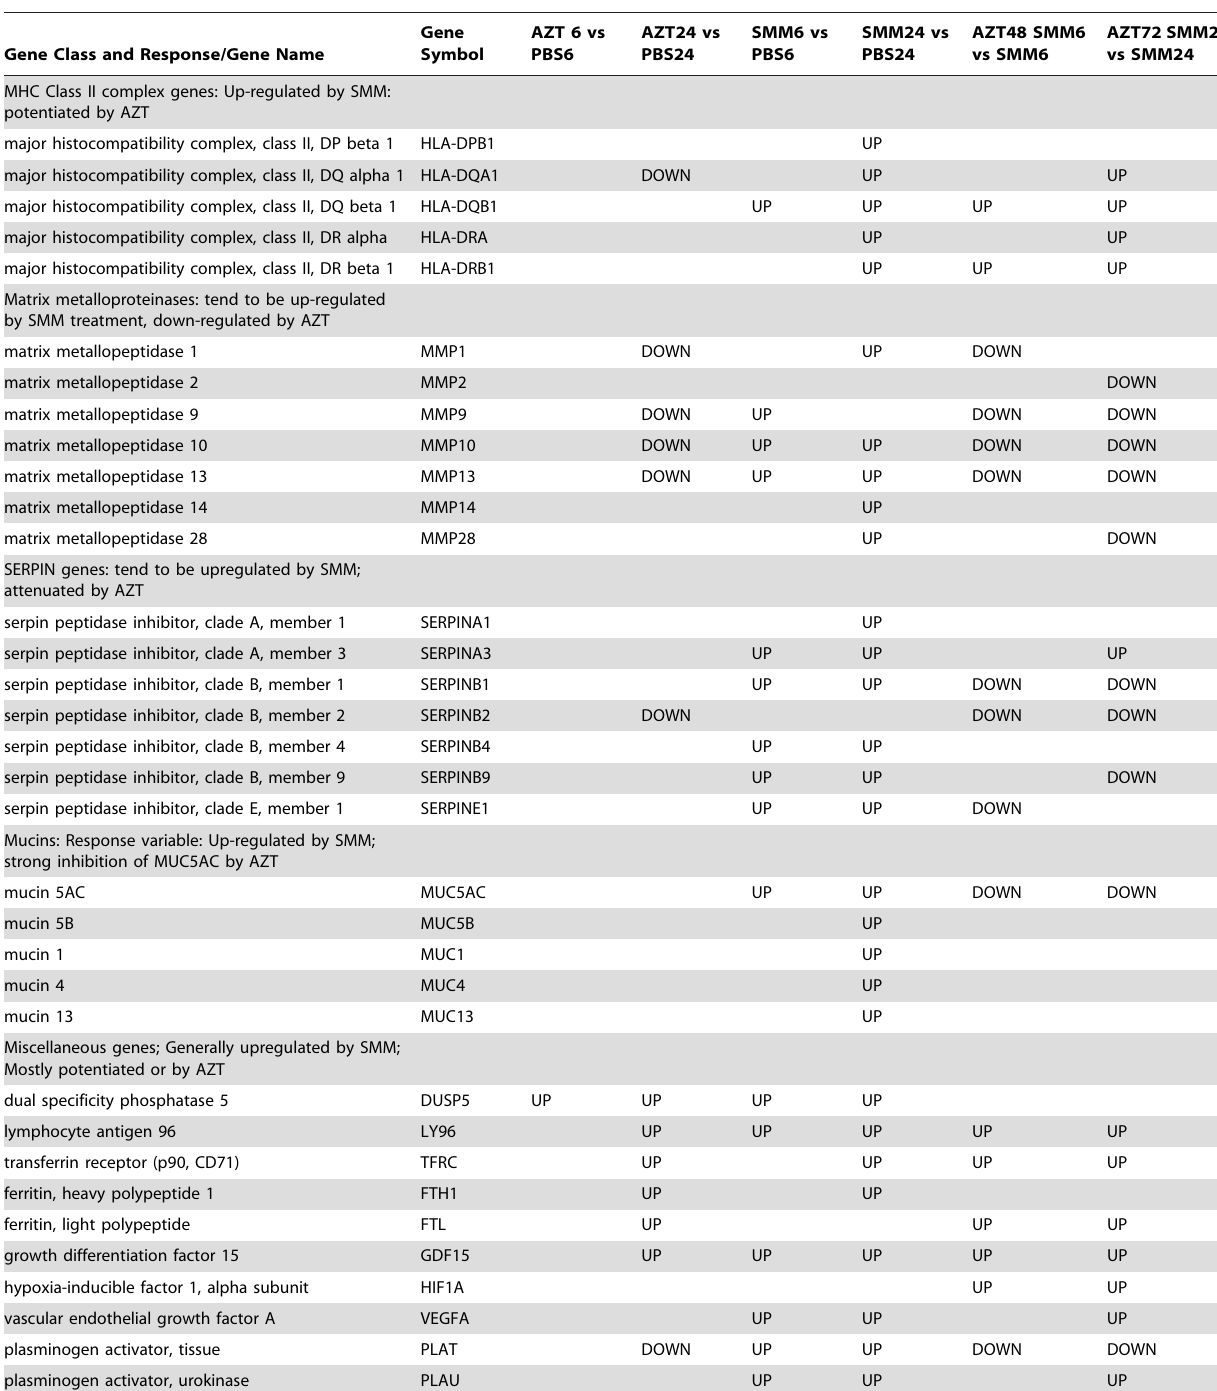
Table 6. Response of selected classes of inflammation-related genes across selected treatment pairs.